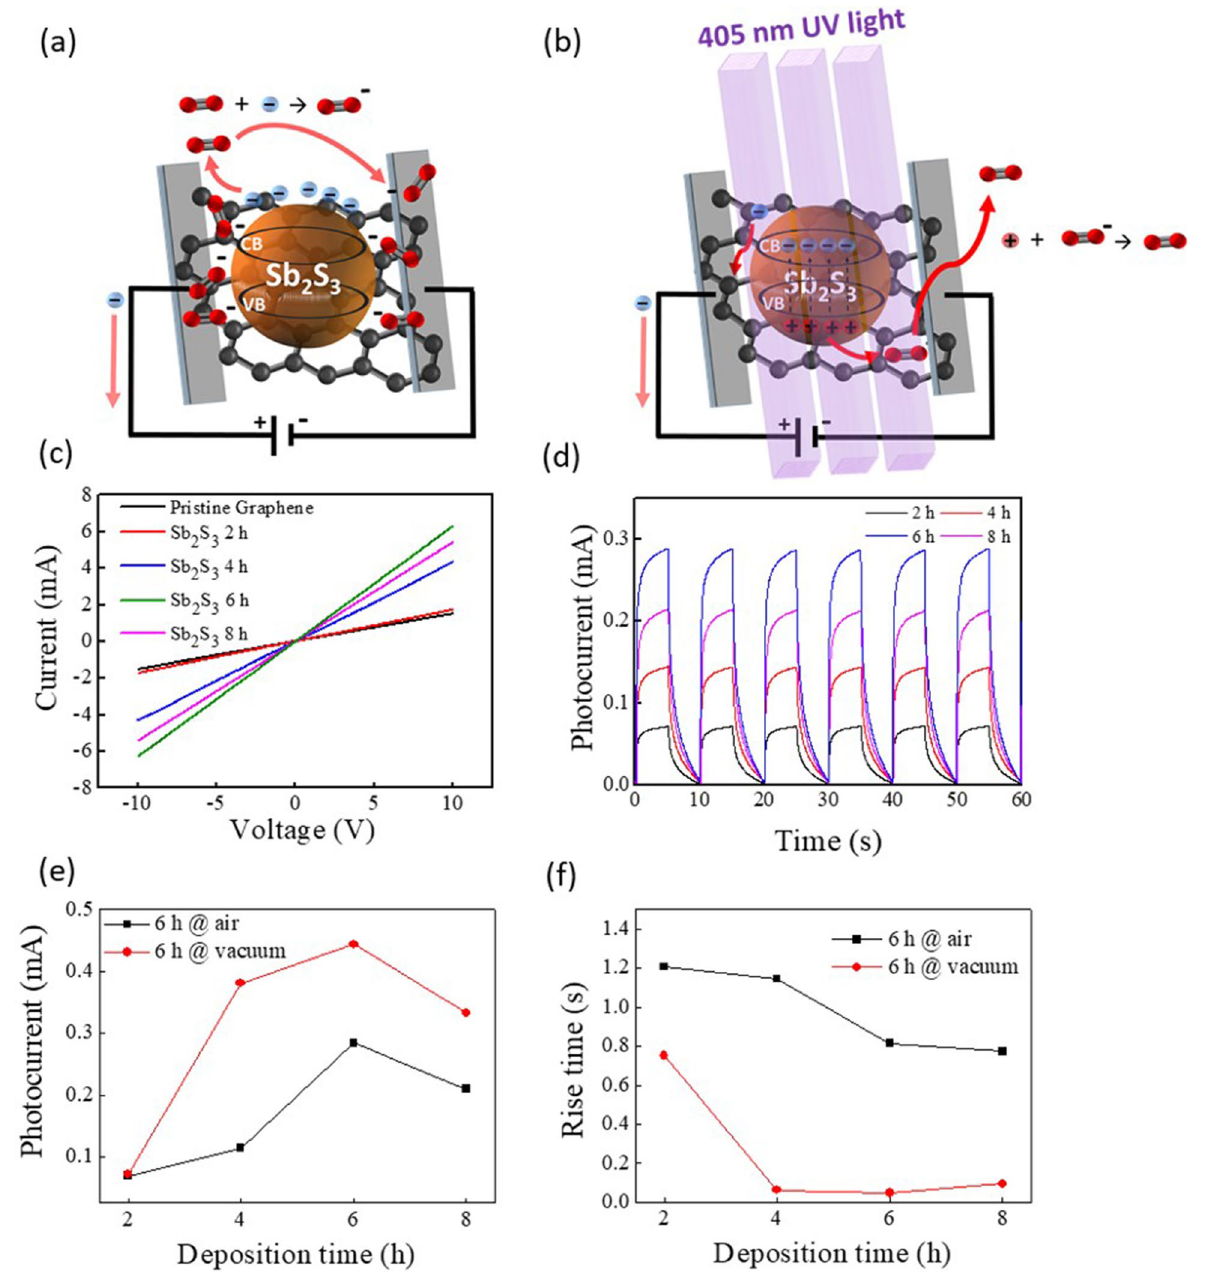
Figure 4. A schematic diagram showing carrier transport of SSG unilluminated ( a ) and illuminated ( b ) by 405 nm lasers, red-colored balls indicates oxygen atoms. ( c ) The I–V curves of SSG photodetector for 2, 4, 6 and 8 h Sb 2 S 3 deposition time, respectively. ( d ) The I–T curves measurements of Sb 2 S 3 at different Sb 2 S 3 thin film growth times on graphene for atmosphere photocurrent, and rise time comparison in 2, 4, 6 and 8 h Sb 2 S 3 deposition time of atmosphere ( e ) and vacuum ( f ),